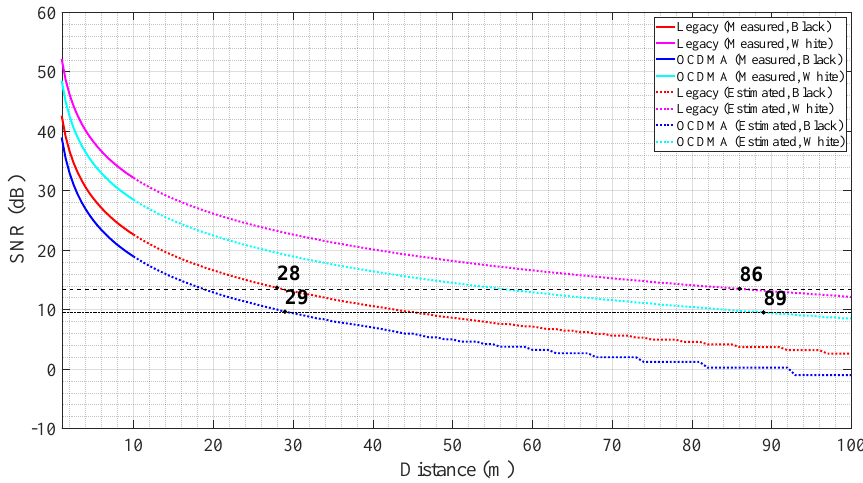
Figure 8. Measured and estimated power with black matte and white paper walls in the legacy and optical code division multiple access (OCDMA) modes. Table 3. Summary of the distance and the power for the black matte and white paper